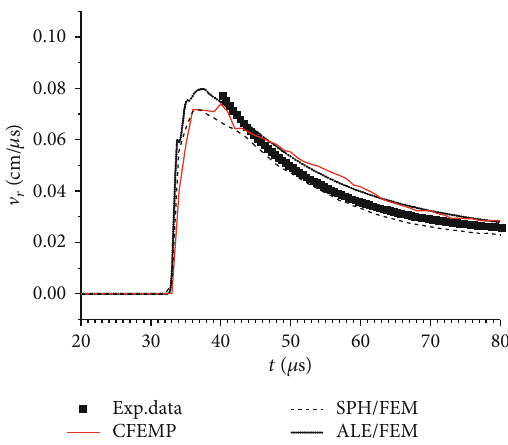
Figure 12: The wall-expanded velocity-time curve at the